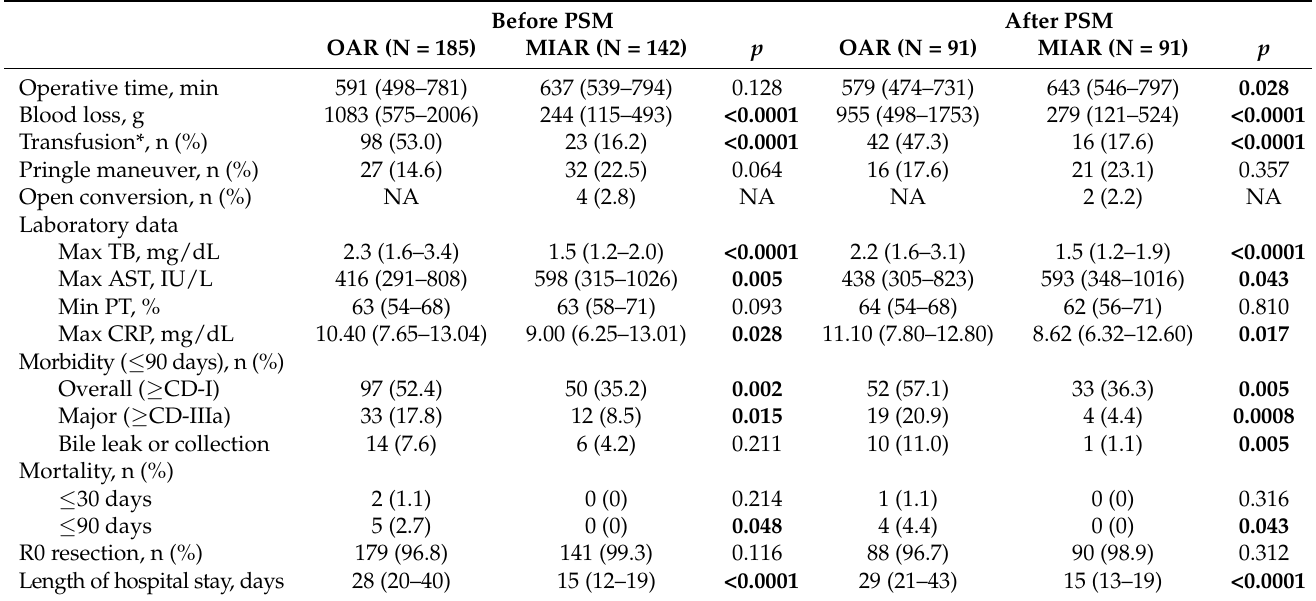
Table 2. Comparison of perioperative outcomes between open and minimally invasive AR for HCC. Before